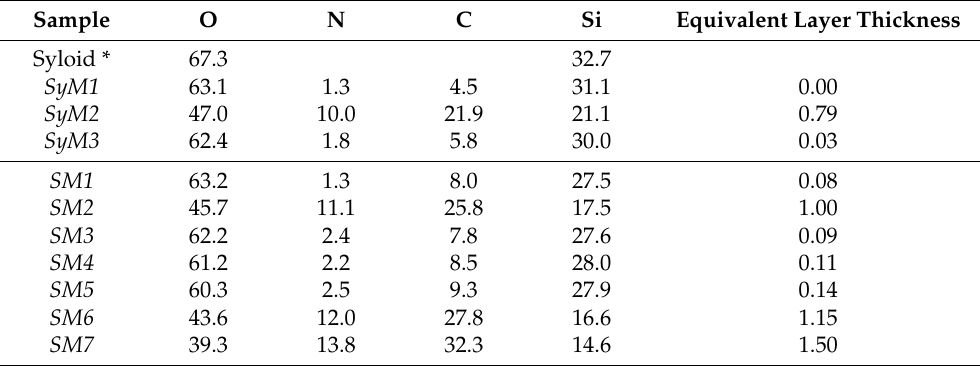
Table 4. Surface chemical composition ( atomic % ) of the metronidazole (MTZ) and Syloid carrier and the adsorbed MTZ samples, calculated by the infinitely thick homogeneous sample model. The last column shows the equivalent layer thickness (nm) of MTZ, calculated by the layers-on-sphere model.